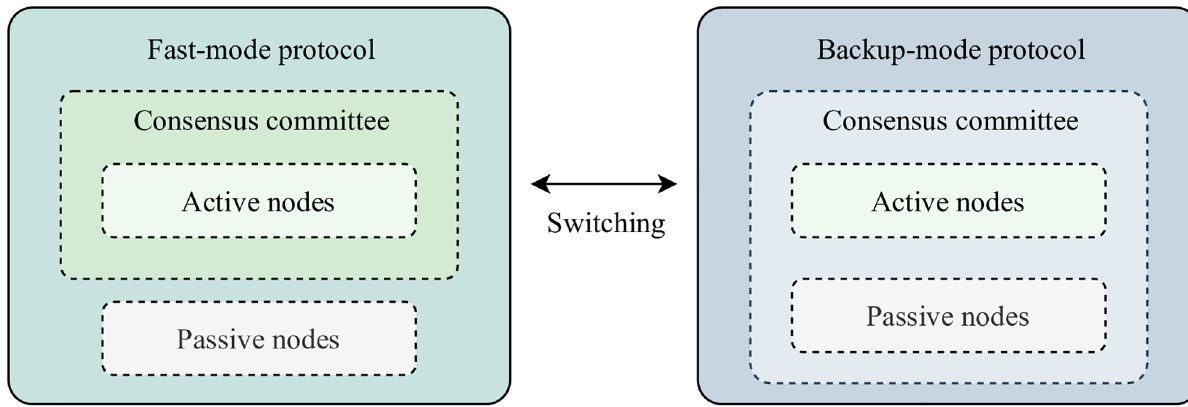
Fig 2. Consensus committee formation for fast-mode and backup-mode